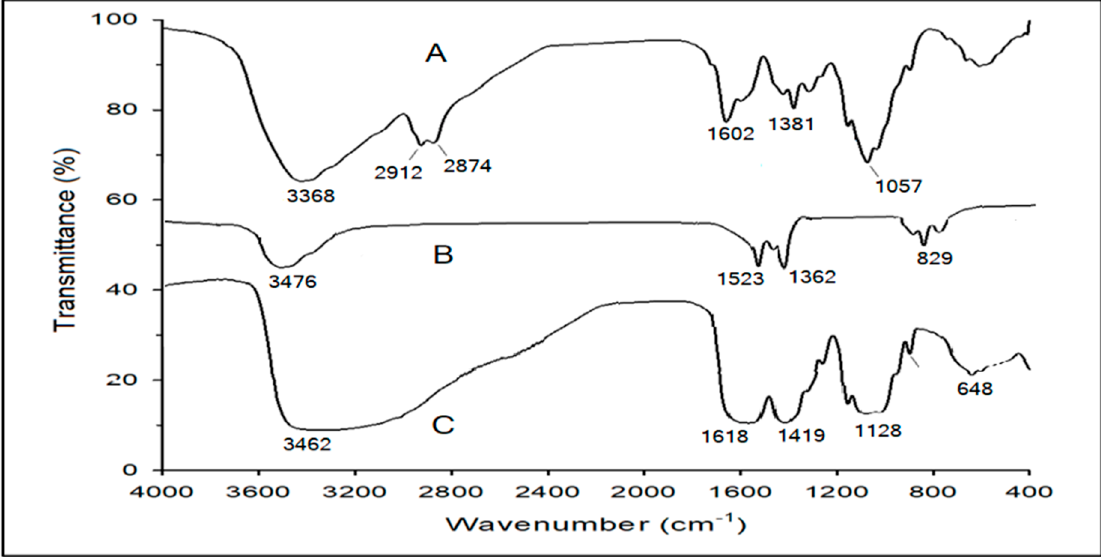
Figure 2. FTIR of chitosan ( A ), La 2 O 3 nanoparticles ( B ), and the chitosan-La 2 O 3 nanocomposite (15 wt%) ( C ).